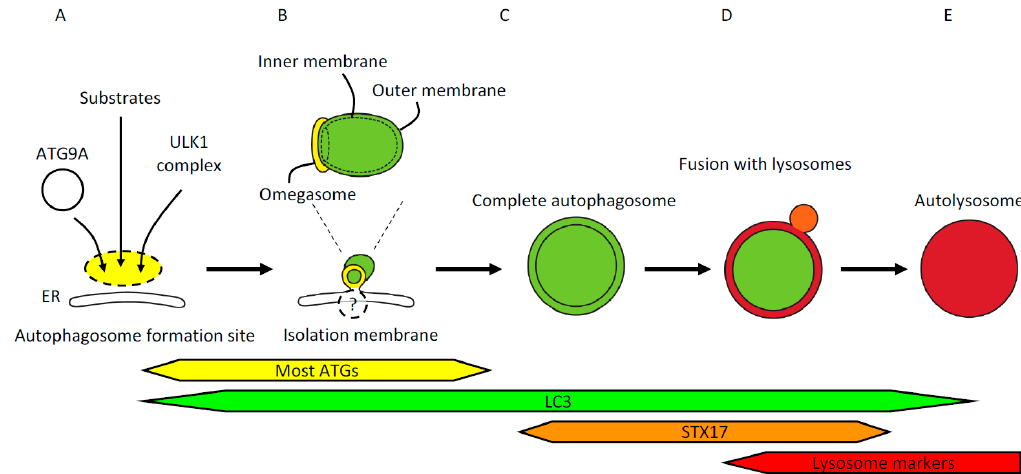
Figure 1. ( A ) The site of autophagosome formation. Upstream autophagy factors and autophagy substrates accumulate at the autophagosome formation site independently from one another. The most upstream autophagy factors are ATG9A in vesicles and the ULK1 complex. Autophagy substrates include p62/SQSTM1, ferritin, and damaged mitochondria. The autophagosome formation site localizes in close apposition to the endoplasmic reticulum (ER); ( B ) Isolation membrane formation. Isolation membranes emerge from within the ring-shaped structure called the omegasome. The omegasome is a phosphatidylinositol 3-phosphate -rich ER subdomain characterized by the existence of double-FYVE domain-containing protein 1 (DFCP1). ATG factors commonly used to visualize